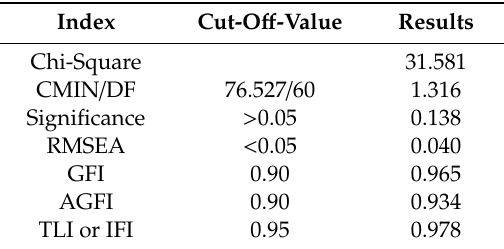
Table 2. Model testing criteria.